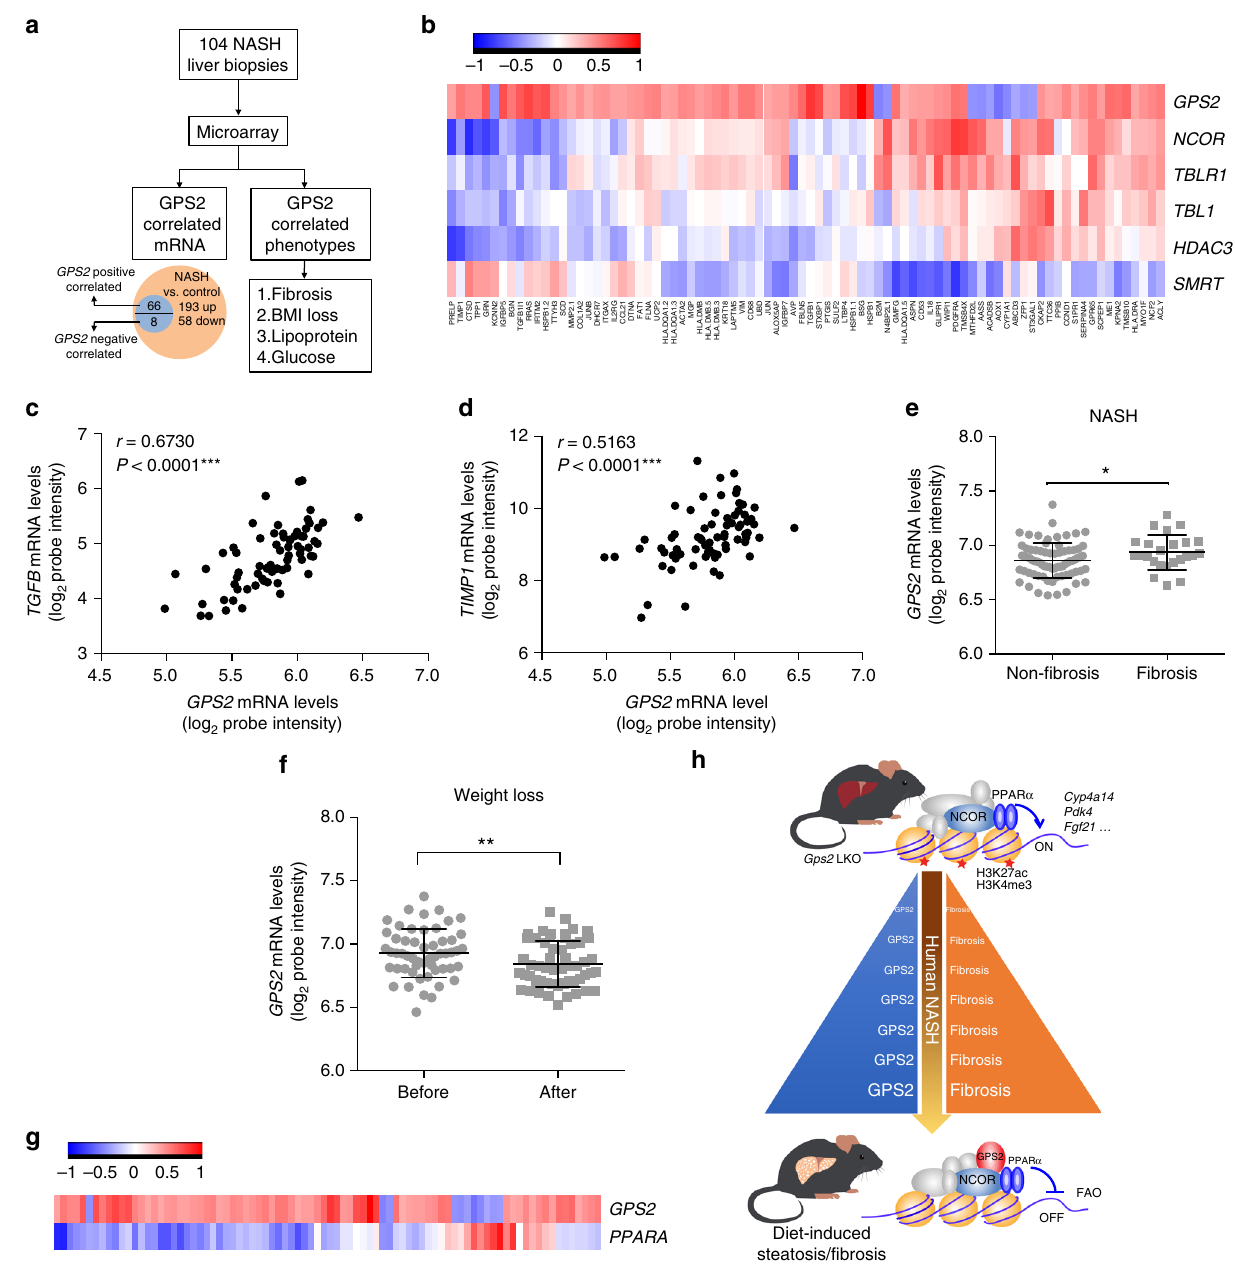
Fig. 6 GPS2 expression associates with NASH and fi brosis in human. a Flowchart representing the analysis of microarray results in the human liver biopsies. b Heatmap representing the rho correlation coef fi cient of GPS2 and other core subunits with NASH-regulated genes in human NASH liver biopsies. c , d Correlation analysis of GPS2 mRNA level with ( c ) TGFB and ( d ) TIMP1 in human NAFLD liver samples (GSE49541), n = 72, non-parametric Spearman ’ s test. e GPS2 mRNA level in non- fi brosis and fi brosis liver biopsies in the NASH subjects, n (NASH non- fi brosis) = 74, n (NASH fi brosis) = 24, unpaired nonparametric Mann – Whitney test. f GPS2 mRNA level in NASH after weight loss in paired obese subjects, n = 54, paired nonparametric Wilcoxon matched-pairs signed rank test. g Heatmap representing the rho correlation coef fi cient of GPS2 and PPARA with NASH-regulated genes in human NASH liver biospies ( n = 104). h Model illustrating the causal relationship between GPS2 expression and PPAR α function in hepatocytes in the context of fatty liver disease. All data are represented as mean ± s.e.m. * P < 0.05, ** P < 0.01, *** P <